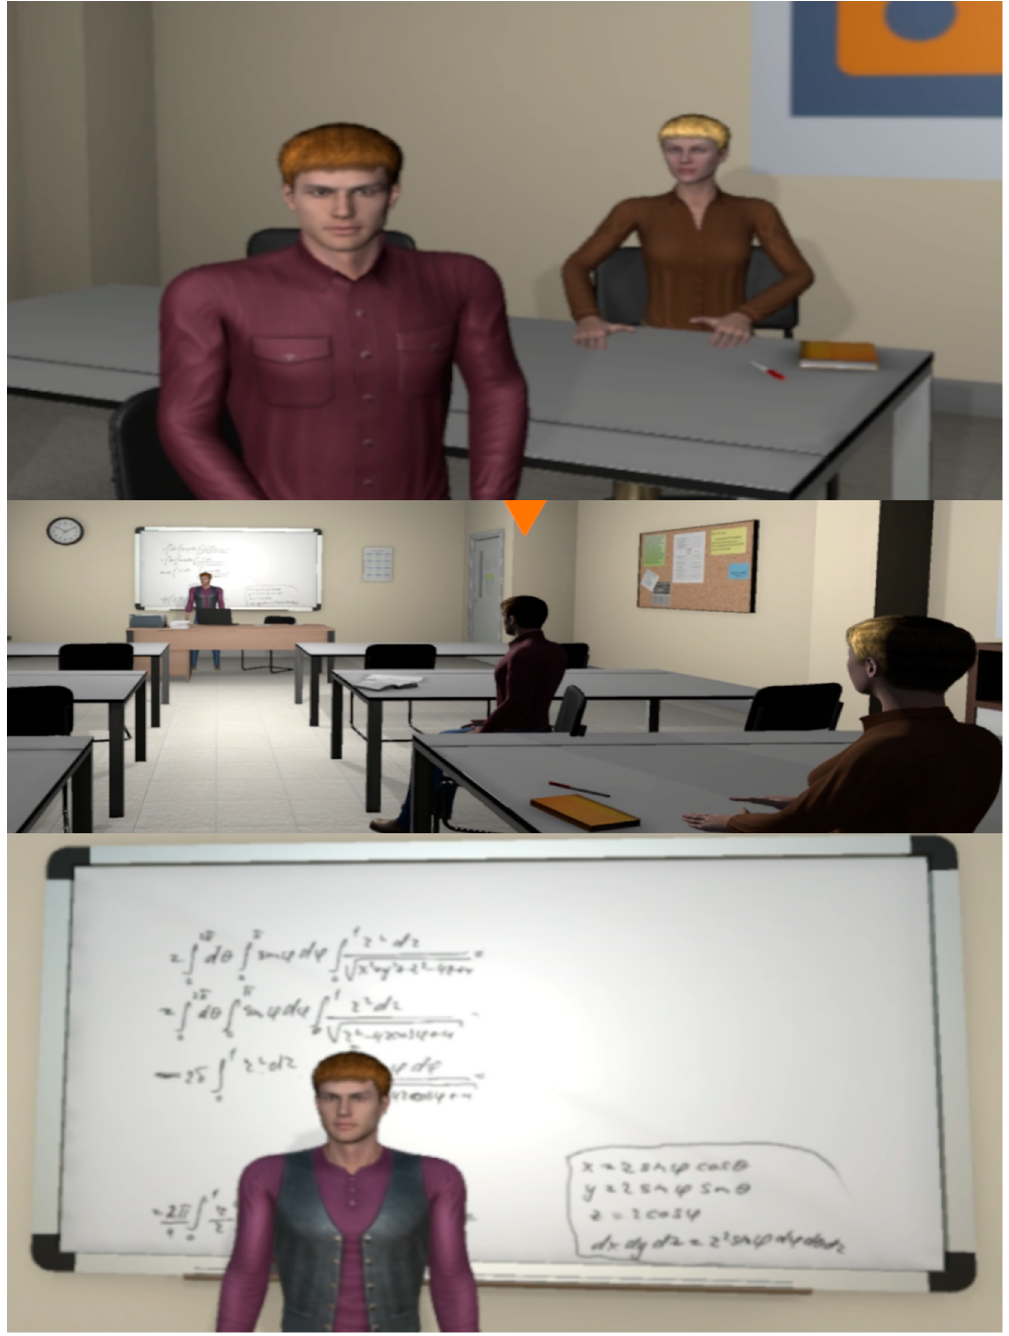
Figure 6. Co-students ( Top ), main area ( Middle ), and lecturer ( Bottom ) of the classroom.